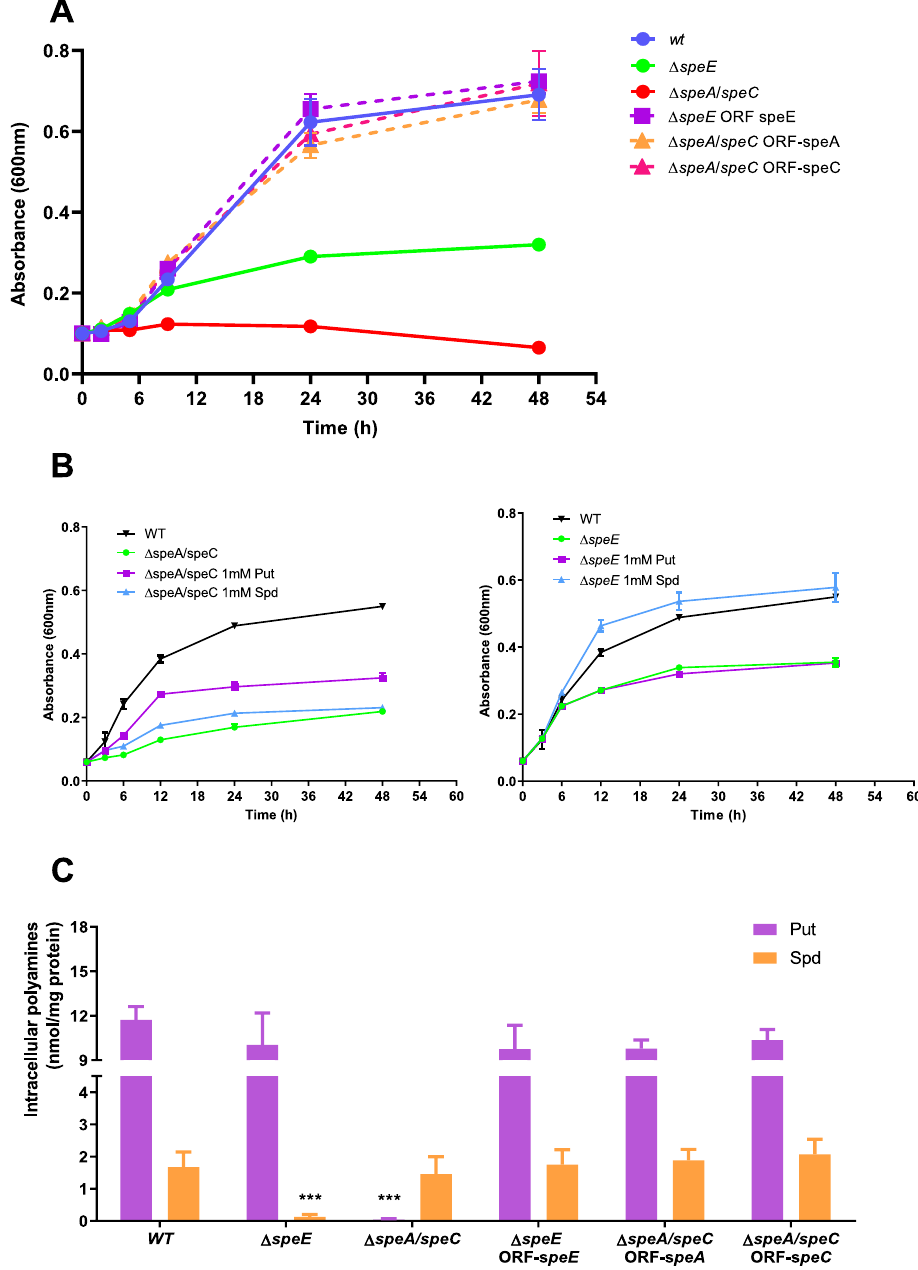
Figure 3. Growth ( A , B ) and intracellular polyamine levels ( C ) in wild type (WT), mutant strains, and reconstituted mutants of Pst DC3000. ( A ) Cells were grown in M9 and the optical density at 600 nm recorded for 48 h. ( B ) The same protocol as in A was used but media were amended the indicated polyamines at a final concentration of 1 mM. ( C ) Samples taken after 12 h were used to determine the intracellular levels of polyamines as described in Materials and Methods. Concentrations in mutants and reconstituted strains were compared to those observed in the wild type using the Student’s t test. ***p <